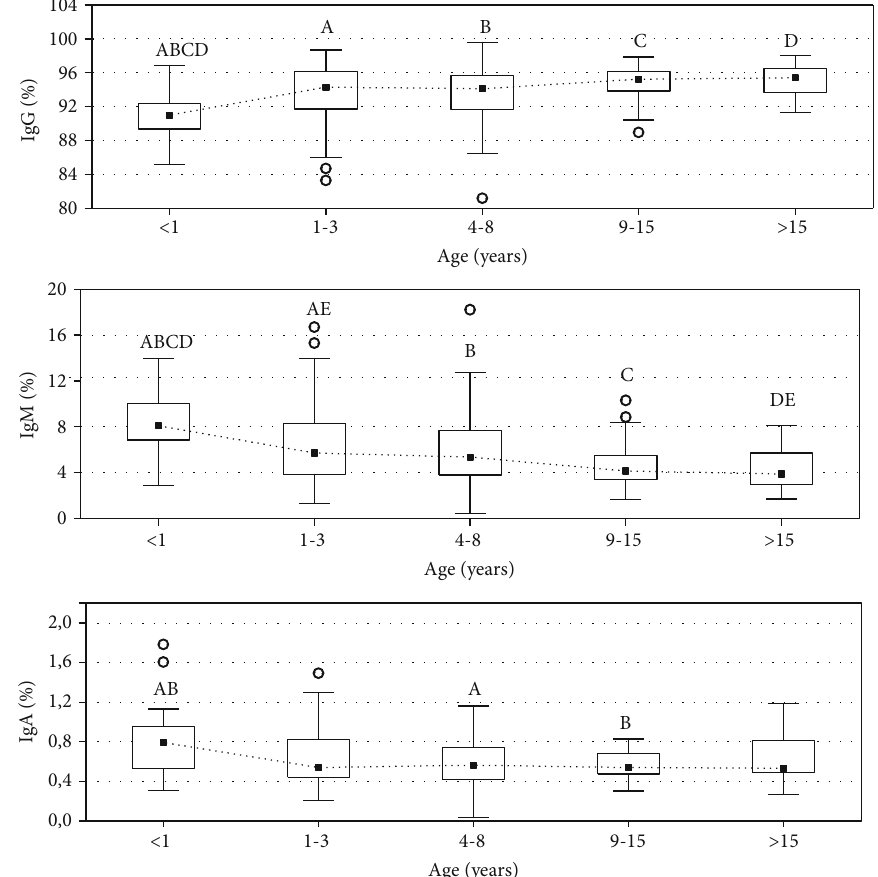
Figure 2: Distribution of the relative concentration (%) of IgG, IgM, and IgA in serum of apparently healthy European bison of various ages. Dotted line represents median values, boxes represent the 25th and 75th percentiles, and error bars indicate the 5th and 95th percentiles for each immunoglobulin class. The circles represent outliers. abcde Values with the same superscript di ff er signi fi cantly between age groups within the same class of immunoglobulin ( p < 0 : 05 ).